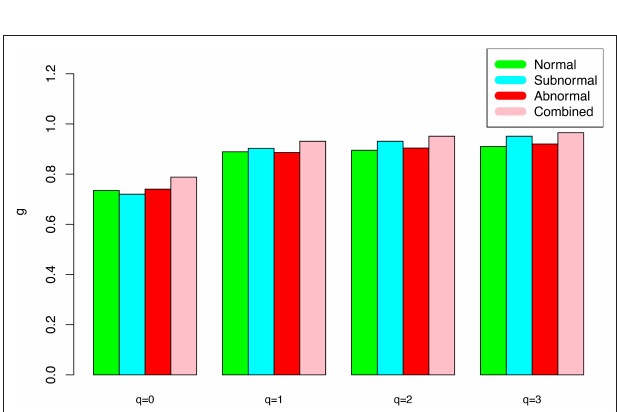
FIGURE 2 | The alpha-PDO profile ( g-q series) for the semen microbiome alpha -diversity at the genus level for normal, sub-normal, abnormal, and combined groups, respectively.